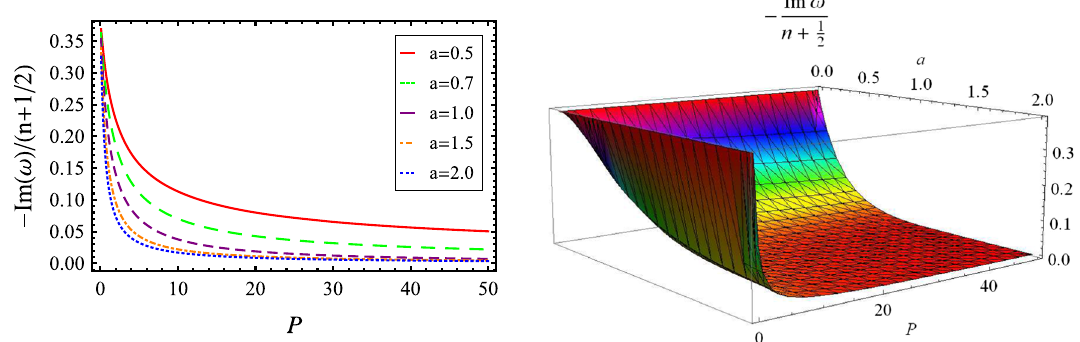
Fig. 3 The dependence (of eikonal limit) of − Im (ω)/( n + 1 / 2 ) on P for different a in the range 0 < a ≤ 2. Here we adopt μ = 1 / 2. Left panel: two dimensional plot. Right panel: three dimensional